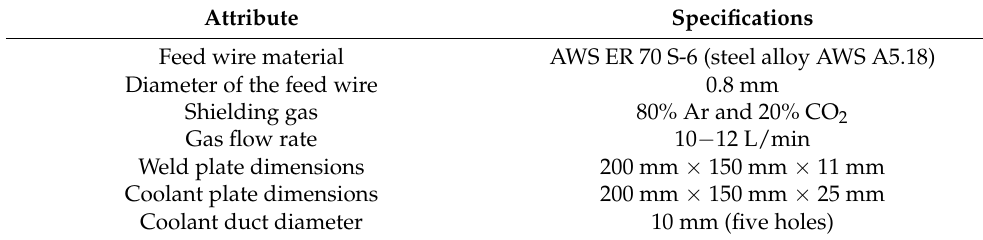
Table 1. Materials used in the experimentation.